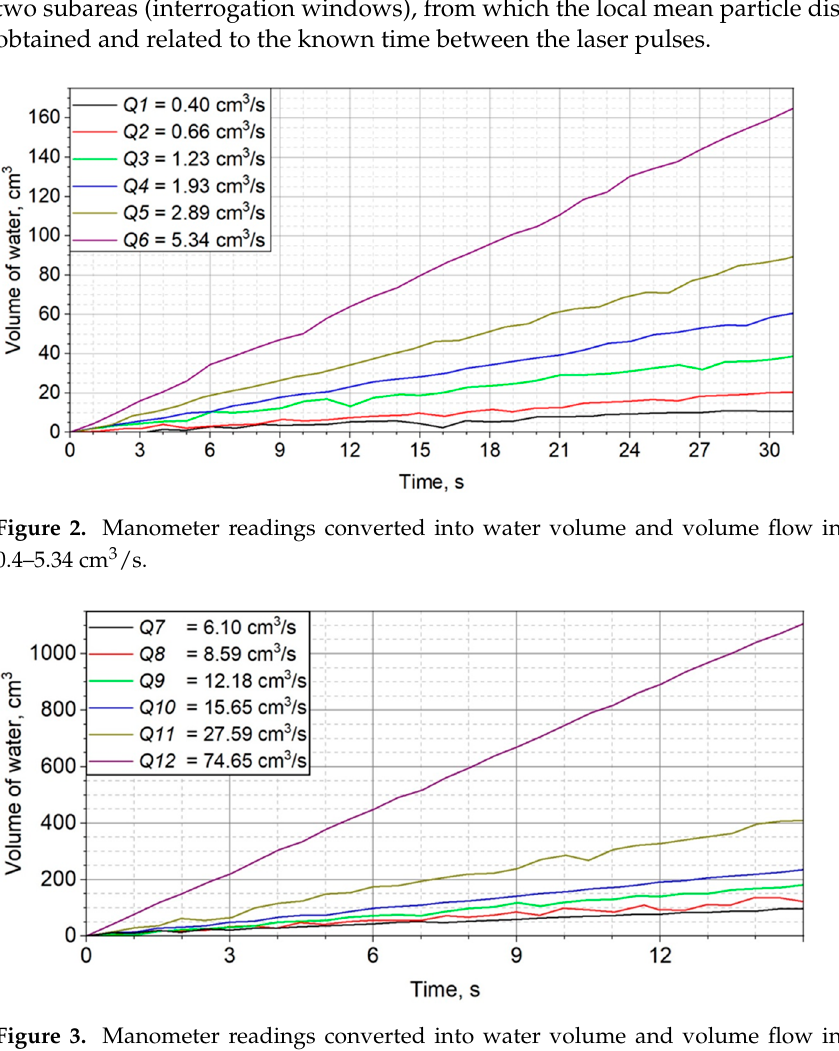
Figure 3. Manometer readings converted into water volume and volume flow in the range of 6.1– 74.65 cm 3 /s.